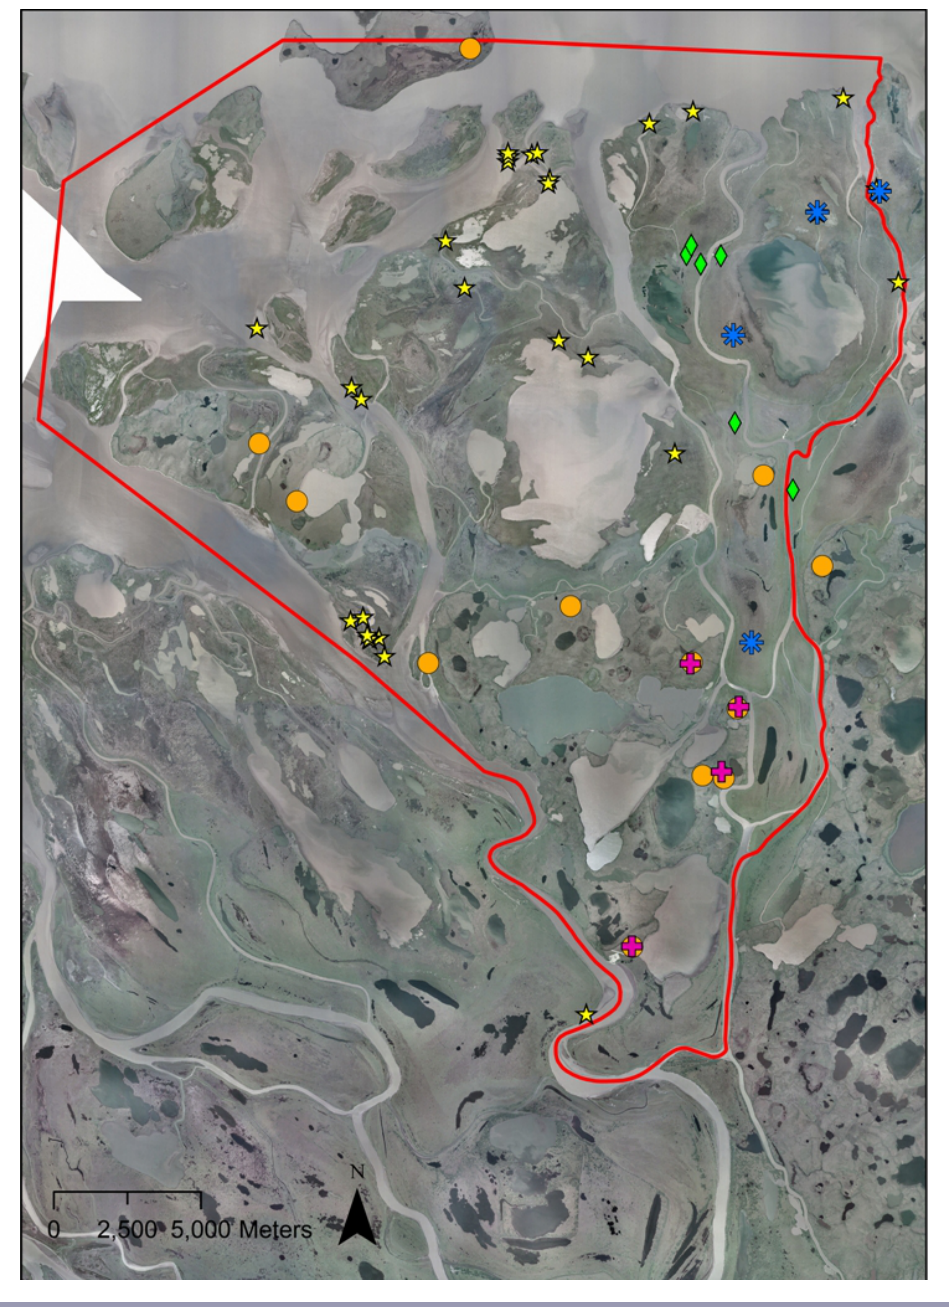
Fig. 5. Locations of surveyed ground-truth plots in KIBS and on Fish Island in the outer Mackenzie Delta, Northwest Territories. Non-shrubby lowland sites (yellow stars); dry upland tundra sites (orange circles); dense shrub lowland sites (green diamonds); low-centered polygon habitat (blue asterisks); areas of observed breeding Whimbrel activities (pink crosses). Survey sites may have extended up to several hundred meters from the marked